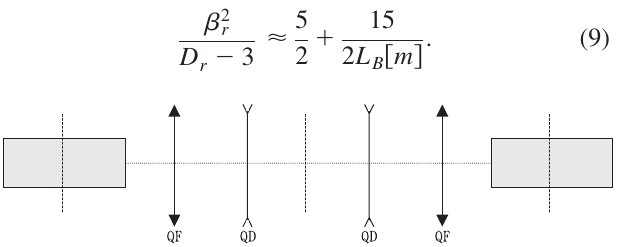
FIG. 1. Layout of a typical TME-like cell, with QF closer to the dipole.